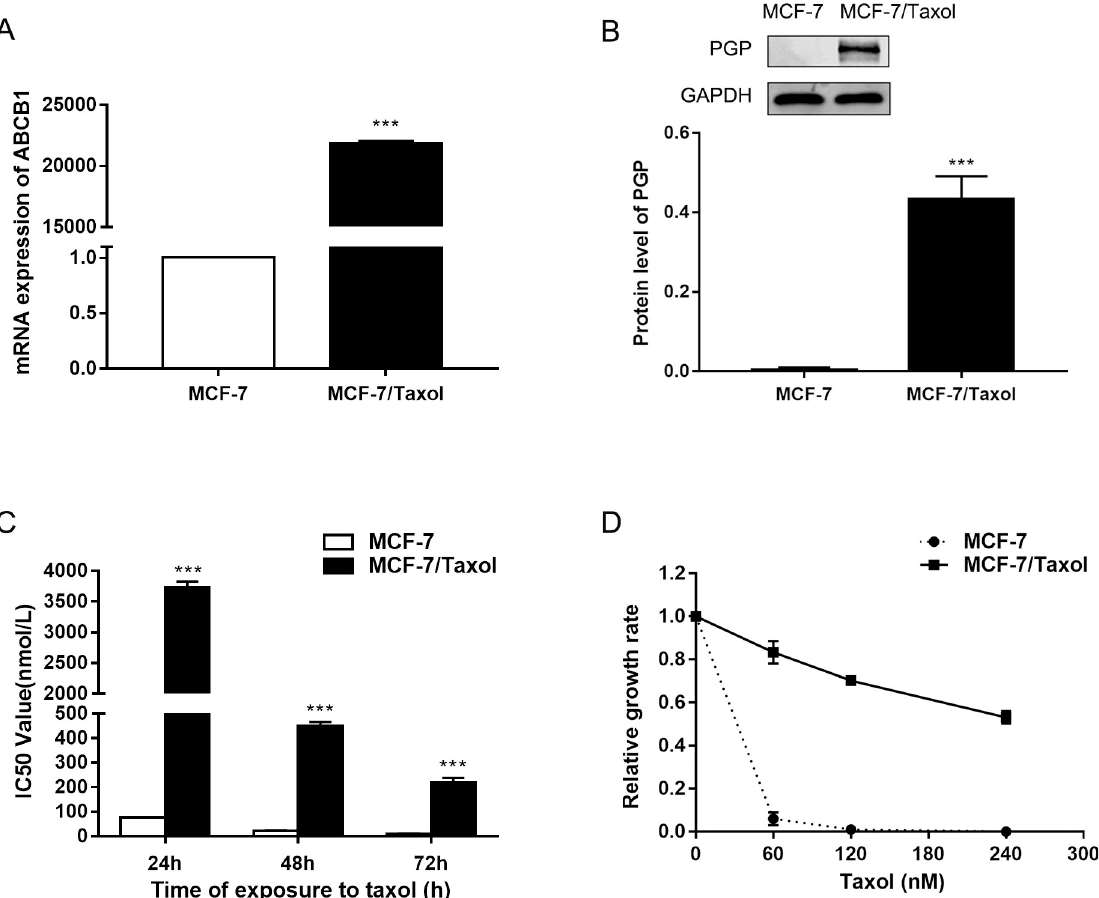
Fig 1. The expression levels of ABCB1 and p-GP are up-regulated in breast cancer MCF-7/Taxol cells. A. Expression levels of ABCB1 mRNA in MCF-7 and MCF-7/Taxol cells were determined by qRT-PCR. GAPDH was used as an internal control. B. Expression levels of p- GP in MCF-7 and MCF-7/Taxol cells were determined by Western blotting. C. Cell proliferation was determined by CCK-8 assay after treatment with Taxol at different time- points (24, 48 and 72h). D. MCF-7 and MCF-7/Taxol cells were cultured in regular medium with different Taxol concentrations (60, 120, 180, 240 and 300 nM), cell number was counted after 72 hours of Taxol treatment. Relative growth inhibition was normalized to cell number of MCF-7 cells without Taxol treatment. Data are expressed as the mean ± SD of three independent experiments. ��� P < 0.001 vs control